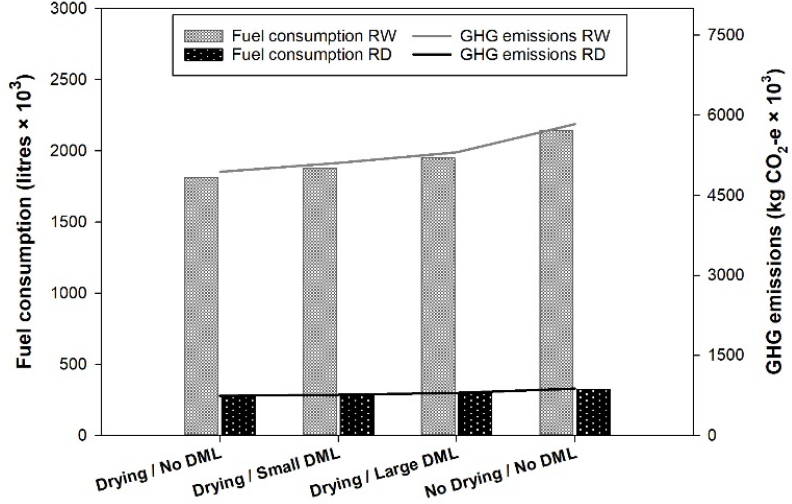
Figure 9. Fuel consumption and GHG emissions by scenario for roundwood (RW) and residues (RD).